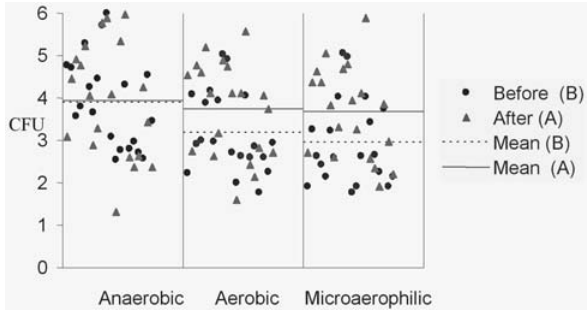
FIGURE 4- Graphic representation of microorganism count logarithms in CFUs relative to Group